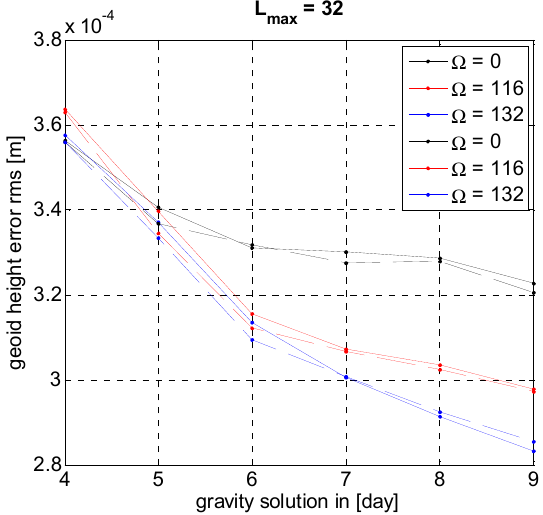
Figure 8. Global error RMS in terms of geoid height for odd (solid line) and even (dashed line) parities (inline scenarios a and b of the Table 2, respectively) for the gravity solutions up to maximum spherical harmonic degree and order 32. Different colors stand for different Ω .